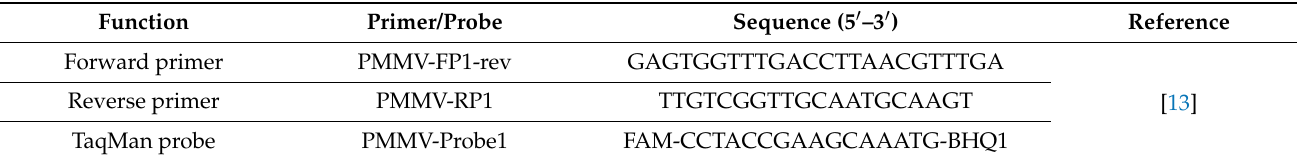
Table 1. Primers and probes used in the RT-PCR